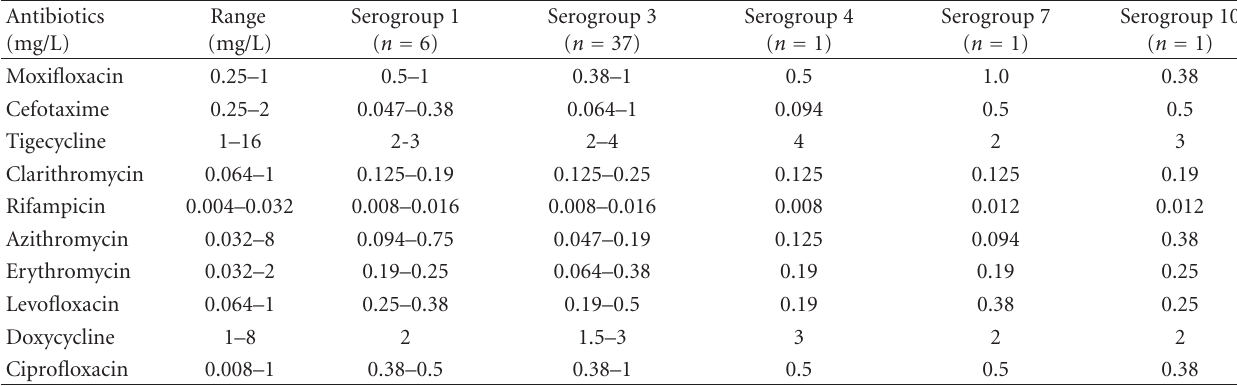
Table 3: Antibiotics MICs for isolated Legionella pneumophila